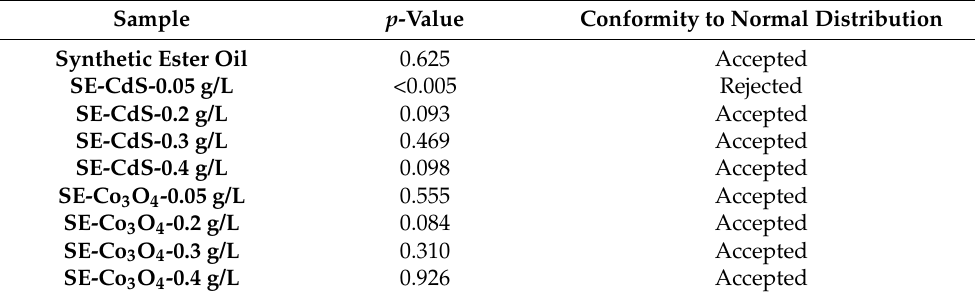
Table 6. Conformity to normal distribution of average AC breakdown voltage of synthetic ester and